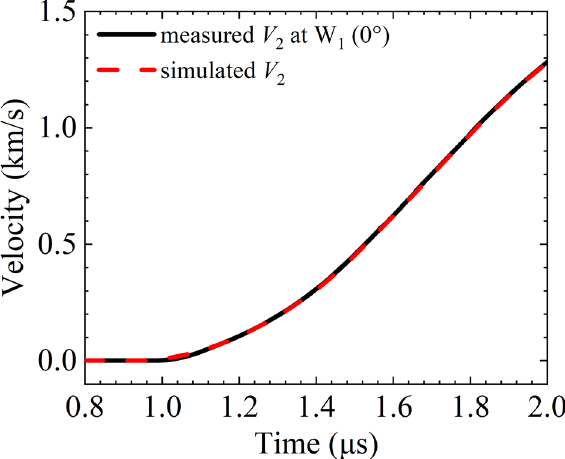
Figure 11. Measured and MHD simulated expansion velocity V 2 curves.